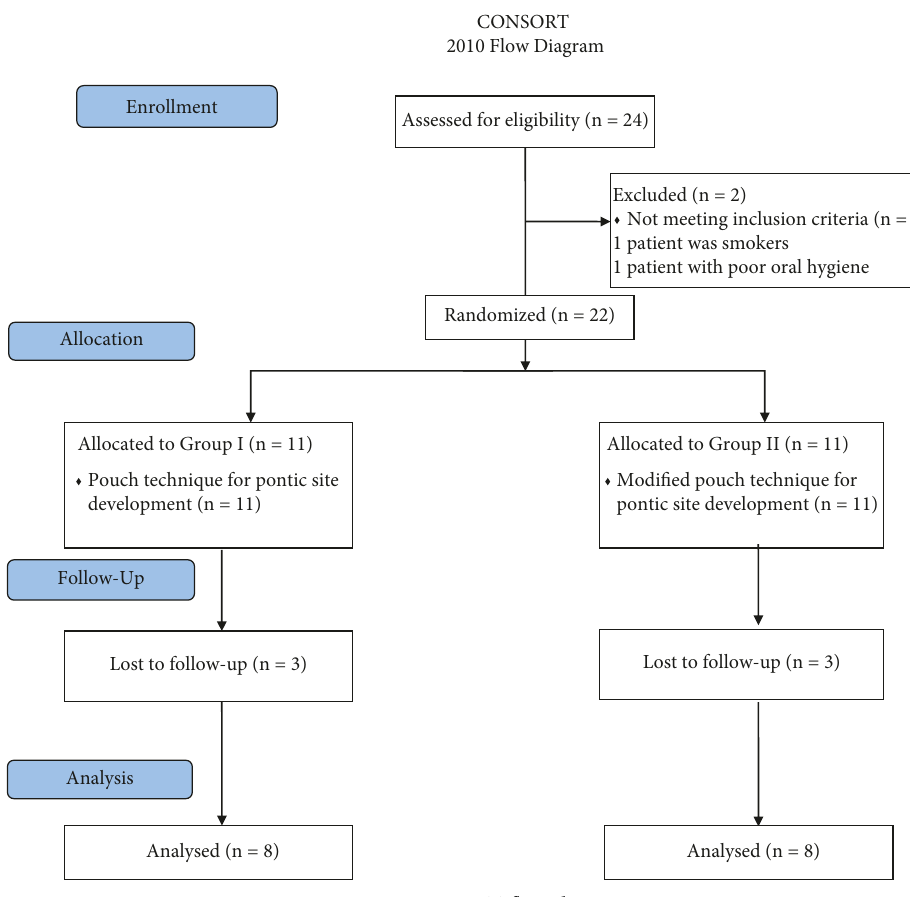
Figure 6: CONSORT flow diagram.